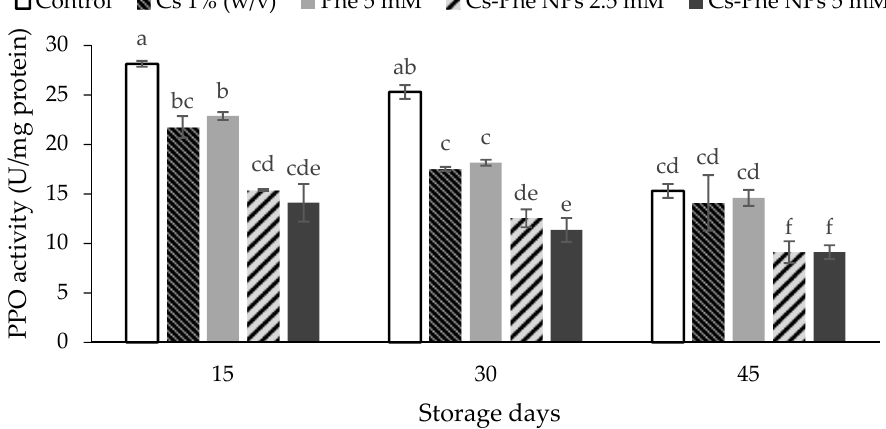
Figure 7. Effects of chitosan, phenylalanine, and chitosan-coated phenylalanine nanoparticles treat- ments on the PPO activity of persimmon fruit during storage at 4 ◦ C for 15, 30, and 45 days. Each value represents the mean ± standard errors of three replications. Different letters indicate statistical differences using Duncan’s multiple range tests at P < 0.05